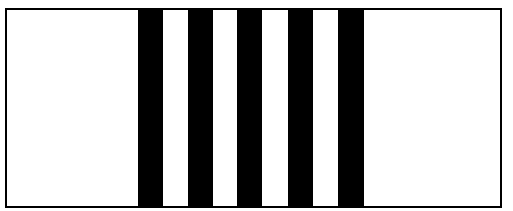
Figure 3. Spatial frequency of a reflecting type Cassegrain